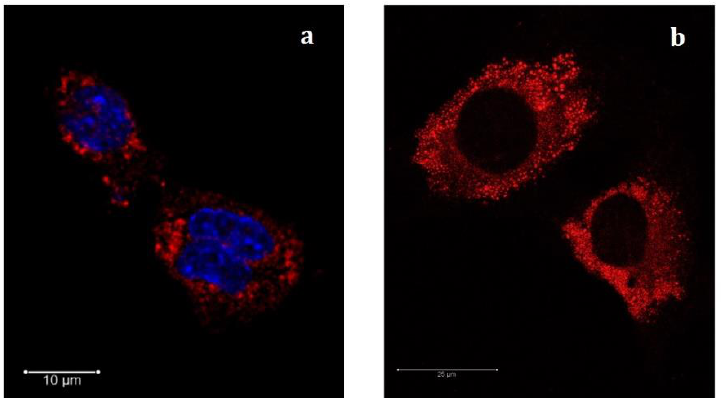
Figure 7. Representative confocal fluorescence images of C2C12 cells exposed to PEA-SLNs-NR (red) during 14 h. SLNs (red channel) and nucleus (blue channel) were stained with Nile Red and DAPI, respectively ( a ); image obtained with no nuclear stain ( b ).